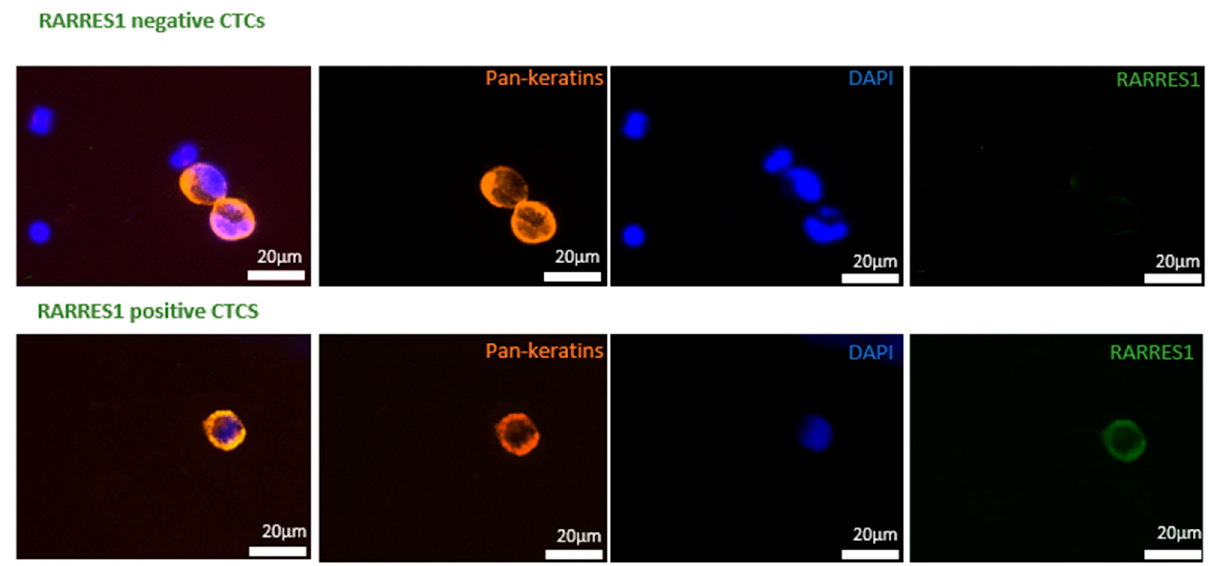
Figure 2. RARRES negative and positive CTCs, with cytokeratine, DAPI, and RARRES1 staining. CTCs detected via immunofluorescence staining. The upper panel shows tow CTCs with no protein expression of RARRES1, whereas the lower panel shows a single RARRES1 positive CTC.